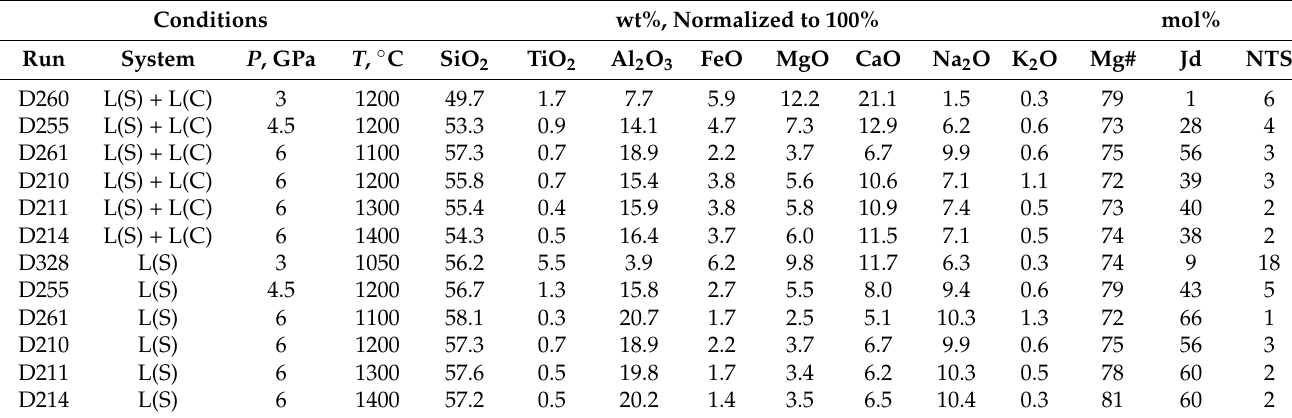
Table 4. Composition of clinopyroxene.